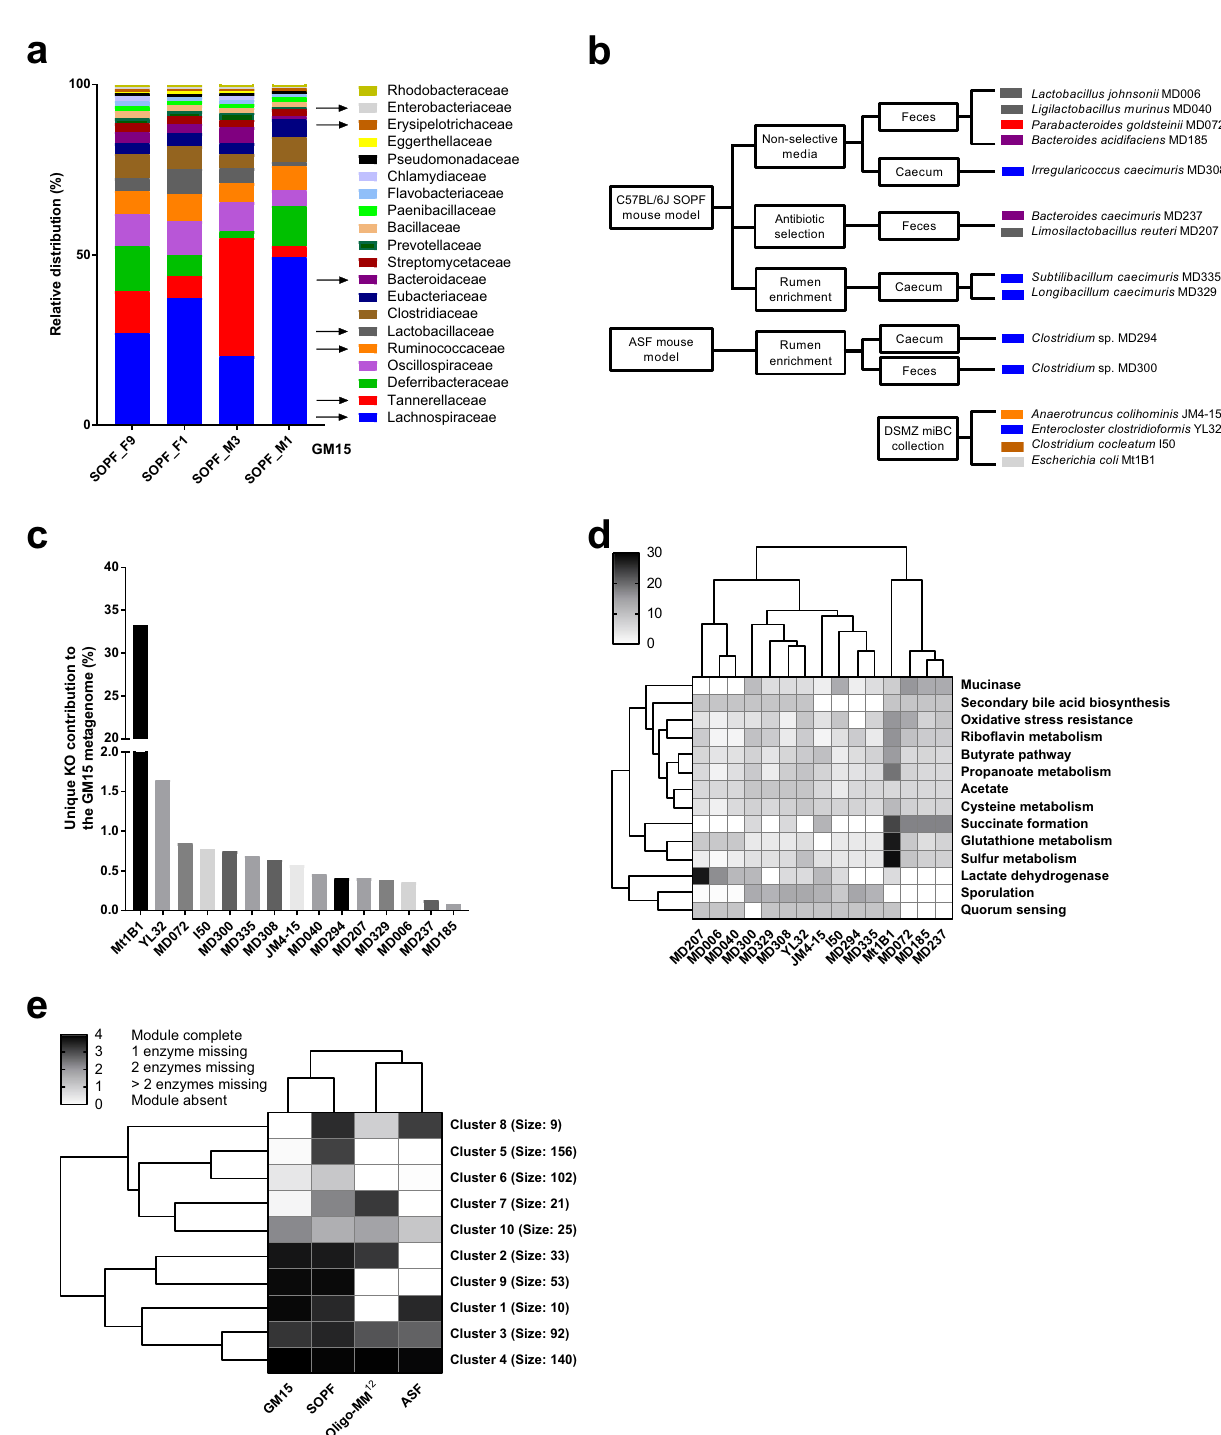
Fig. 1 Selection, isolation, and functional analysis of GM15 strains. a Representative and prevalent bacterial families identi fi ed from fecal samples of 4 C57BL/6J mice of our colony. b Eleven bacterial strains were isolated from fecal or cecal samples of either C57BL/6J or ASF mice using various culture methods. Four additional strains were obtained from the DSMZ collection. c Unique KO (KEGG Orthology) groups are those present in only one GM15 member. The unique contribution of each GM15 member is relatively evenly distributed (<2%), except E. coli whose unique functions contribute for 33%, although nonunique KO groups are primarily responsible for the GM15 ’ s metagenomic pro fi le with 59% of the contribution. d Heatmap of hierarchical clustering of enzymatic activities in the gut for the 15 strains of the GM15 model. In quorum sensing (QS) function, only effector proteins were screened (because receptors suffer from similarities with nonspeci fi c QS receptors). e Heatmap of hierarchical clustering of KEGG module distribution in the metagenomes of GM15, SOPF, ASF, and Oligo-MM 12 models. Clusters of KEGG modules are highlighted with their respective size (number of KEGG modules). The list of KEGG modules and clusters is shown in Supplementary Data 1. Source data are provided as a Source Data fi